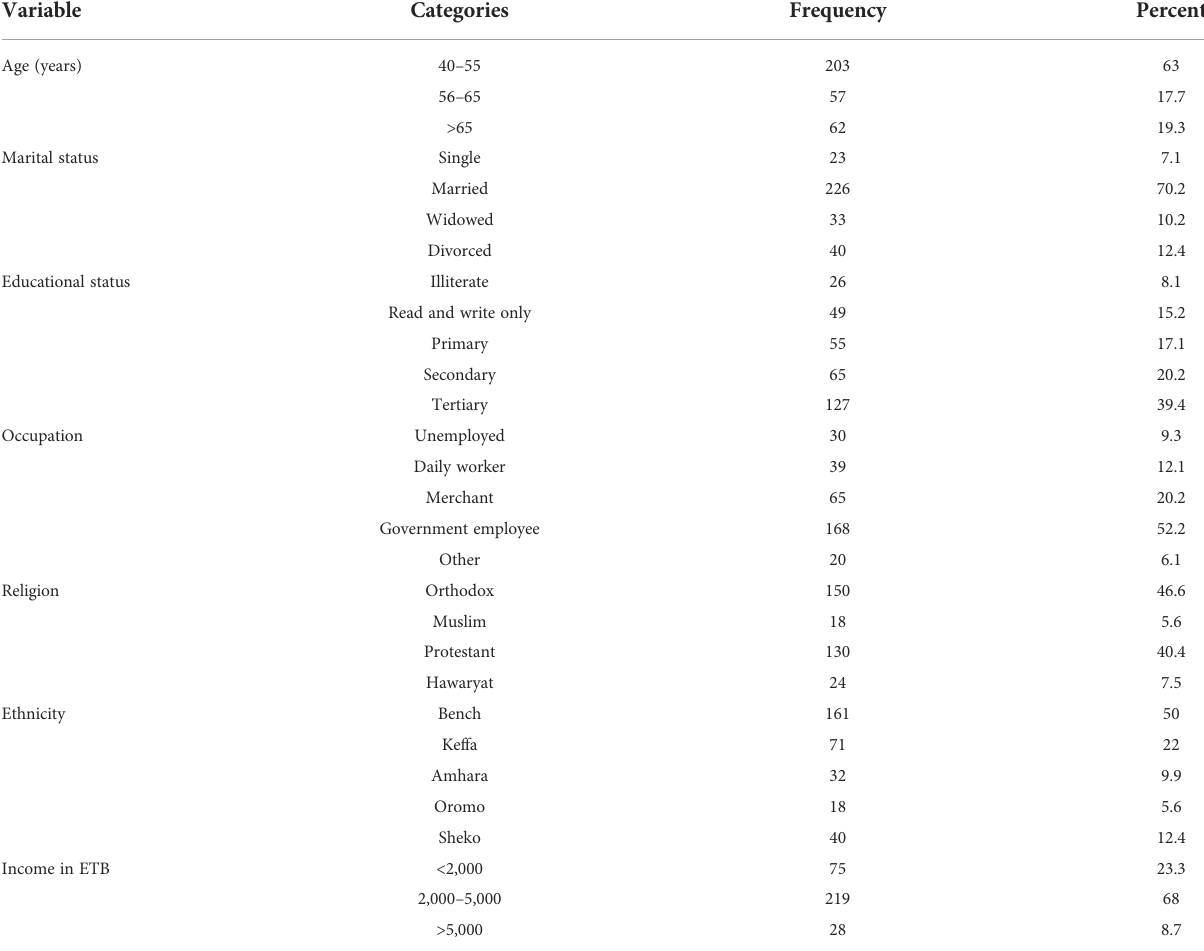
TABLE 1 Sociodemographic characteristics of men 40 years of age and older in Mizan Aman town, Bench Sheko zone in SNNPR, South West Ethiopia, 2019.